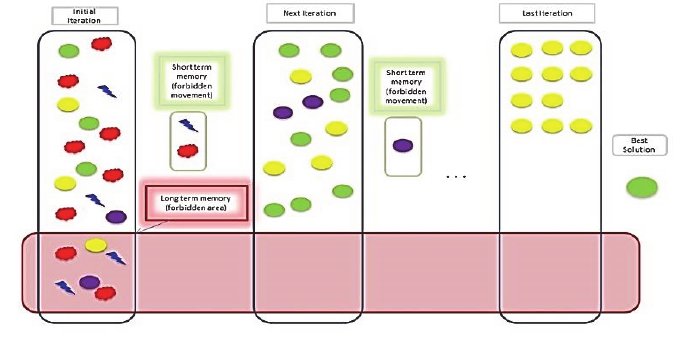
Fig. 2. Scheme of Tabu Search